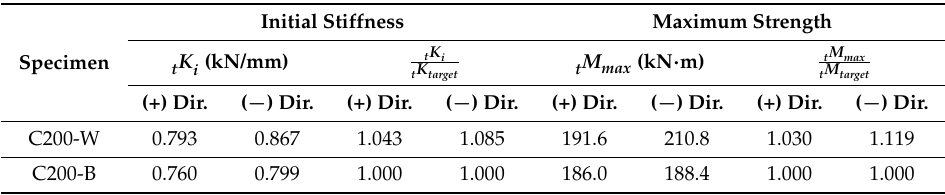
Table 9. Comparison of a welded joint with a bolted joint.